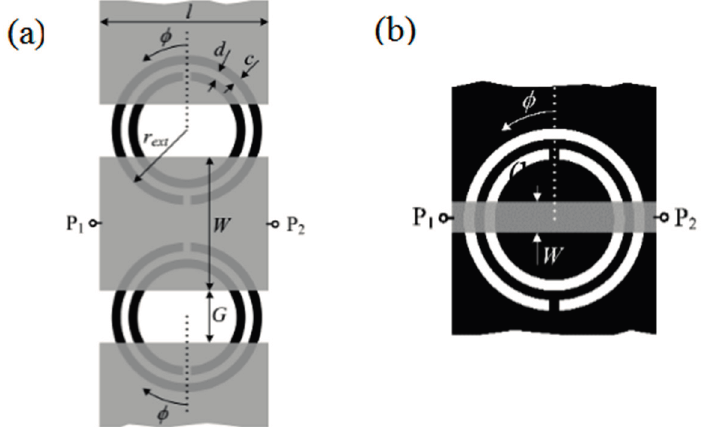
Figure 1. ( a ) CPW (Coplanar waveguide) transmission line loaded with a pair of SRRs (split ring resonators) with the symmetry plane orthogonally oriented to the line axis; ( b ) Microstrip transmission line loaded with a CSRR (complementary split ring resonator) with the symmetry plane orthogonally oriented to the line axis. If the particles are rotated ( ϕ ≠ 0), mixed coupling